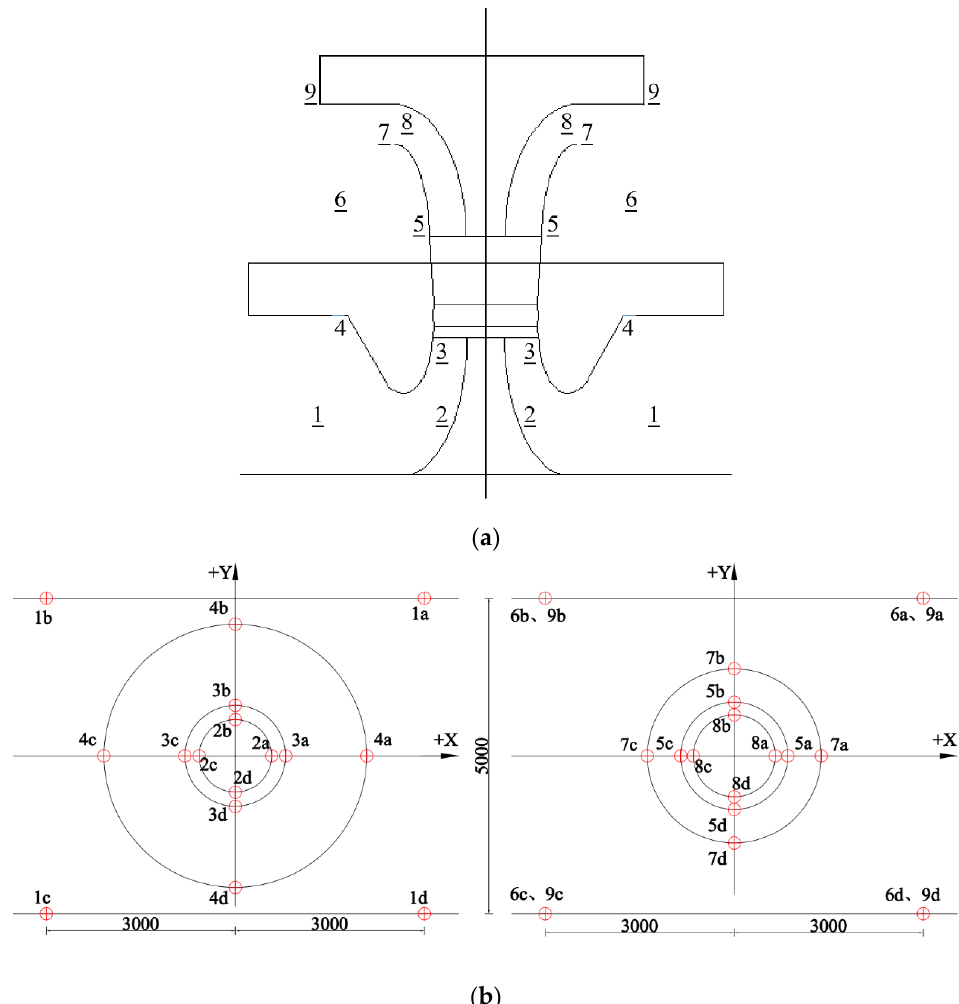
Figure 7. Layout of pressure fluctuation monitoring points: ( a ) layout of flow channel monitoring section; ( b ) layout plan of the pressure fluctuation measuring points. Red ring representative monitoring points.